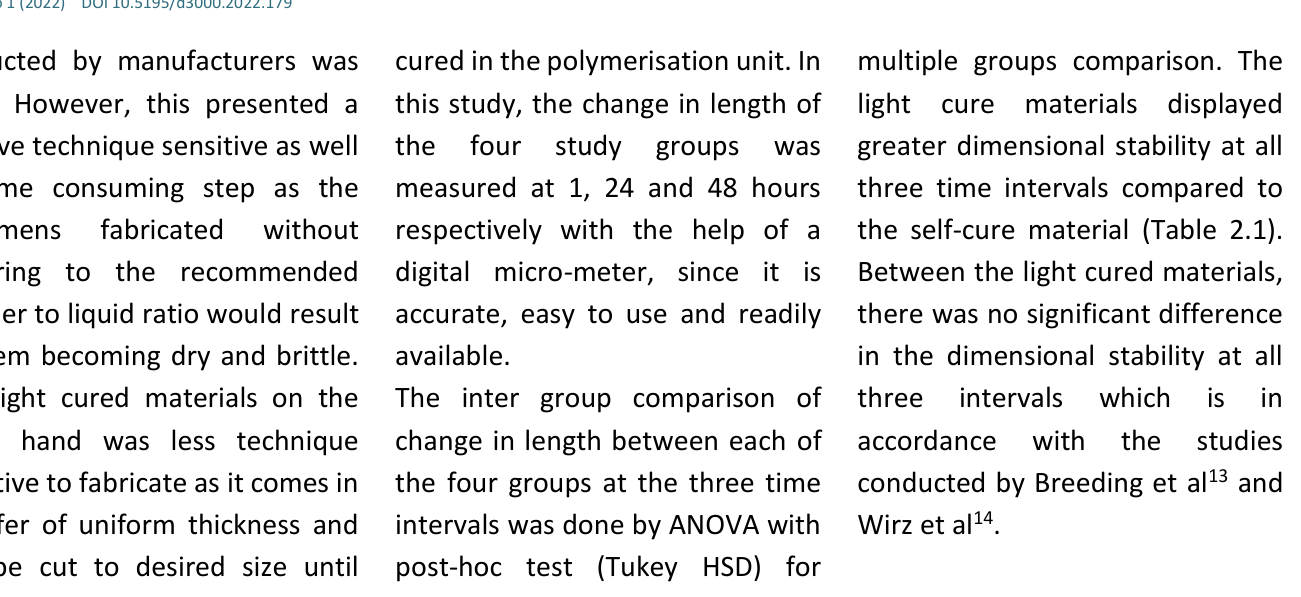
Table 2.1 : Inter group comparison of change in length of the four test groups at different intervals: